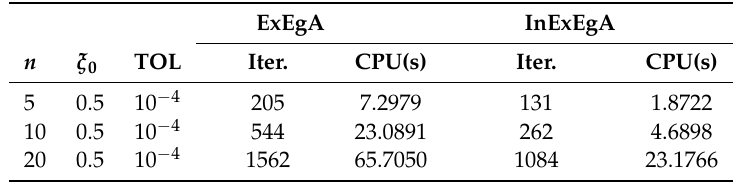
Table 2. Example 3: The numerical results for Figures